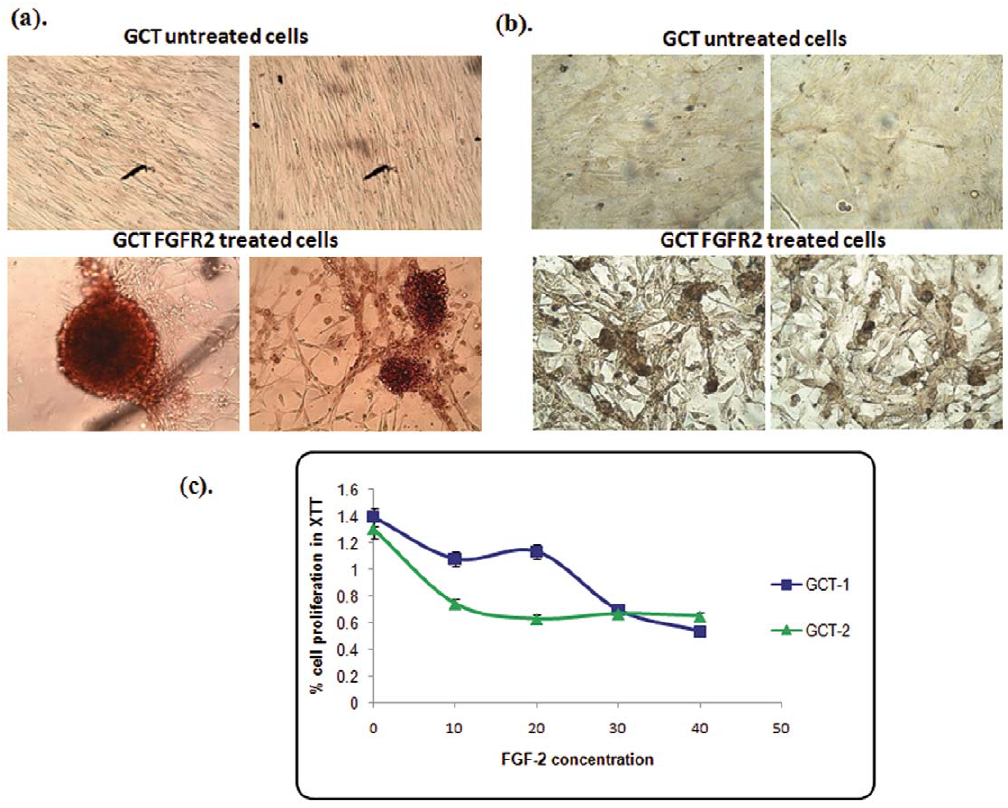
Figure 2. Bone nodule forming assay. ( a ). GCT stromal cells were induced into osteoblastic differentiation by exposure to FGF-2. Alizarin staining was used for bone nodules, and visualized by phase-contrast microscopy. ( b ). Von Kossa staining were used to determined GCT stromal cells osteoblastic differentiation by exposure to FGF-2. Bone nodules are visualized by phase-contrast microscopy. ( c ). XTT assay. A decreased number of mitochondrial active cells were seen in FGF-2 treated cells when compared to untreated GCT stromal cells. GCT untreated cells were used as a control (CT).